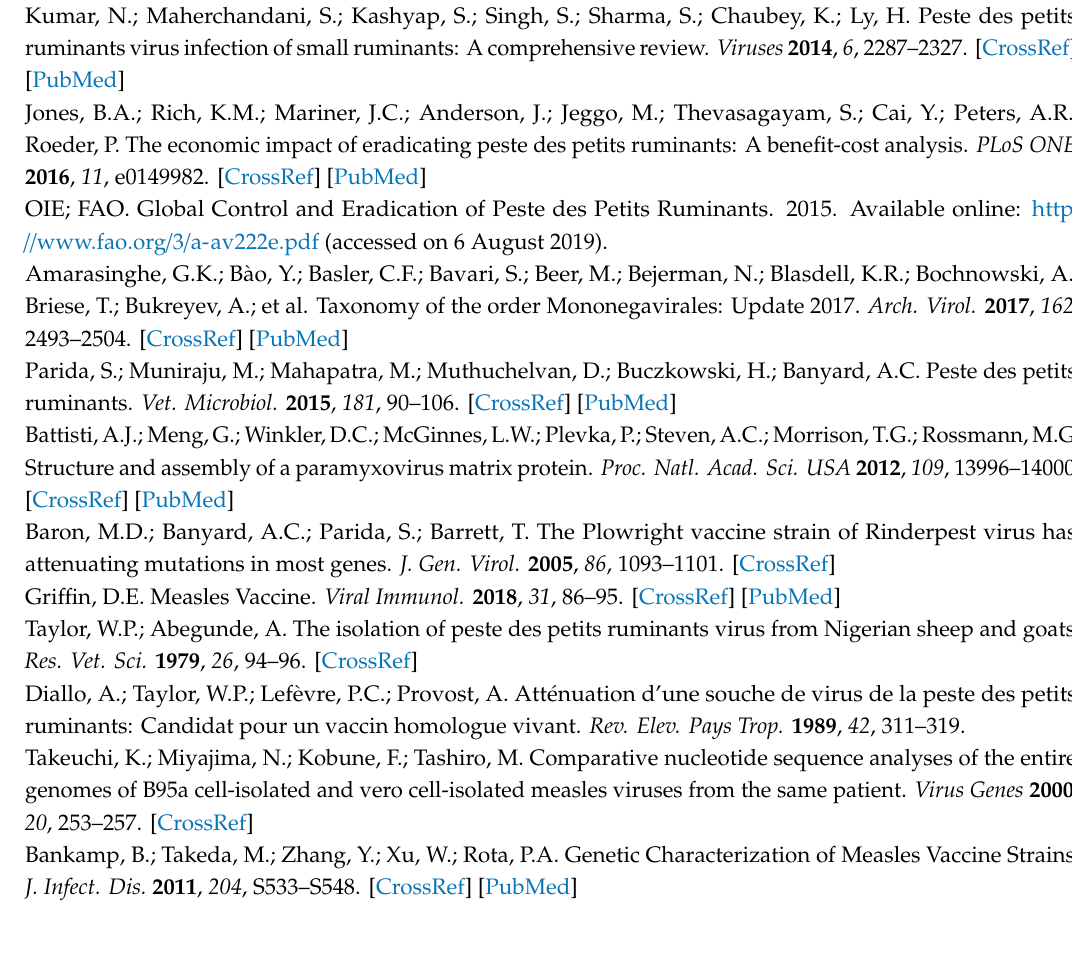
Table S1: Primer set used for long fragment analysis of the PPRV genome, Table S2: Pairwise Manhattan distances calculated based on the base frequencies and the consensus sequences (diagonal from top / left to bottom / right highlighted in bold), the base frequencies in the populations (above the diagonal), or the consensus sequences (below the diagonal), respectively; Figure S1: Chromatogram alignment of the RACE PCR Sequencing, Figure S2: Variants appeared and / or disappeared during cell passages, Supplementary FASTA file: Genomes